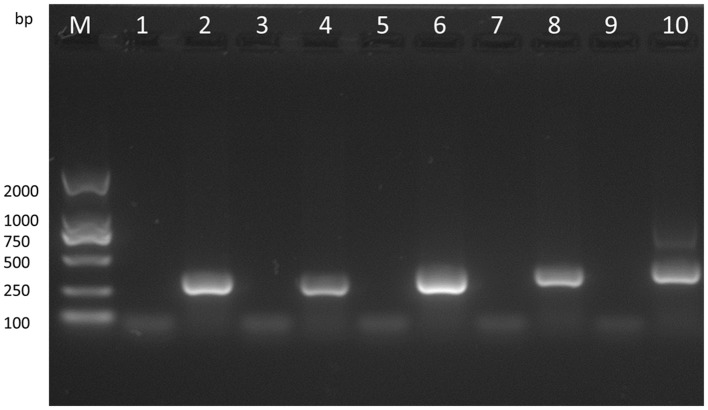
Analysis of the recombinant virus MVTTEAB by PCR. PCR was performed to identify the final mutant MVTTEAB. Lane 2: positive control containing the TC7L-TK2L gene (322 bp), lane 4: positive control containing the TE3L gene (359 bp), lane 6: positive control containing the TA35L gene (307 bp), lane 8: positive control containing the TB13R gene (406 bp), lane 10: positive control containing the TA66R gene (352 bp), and lanes 1, 3, 5, 7, and 9: PCR products of the MVTTEAB genome.